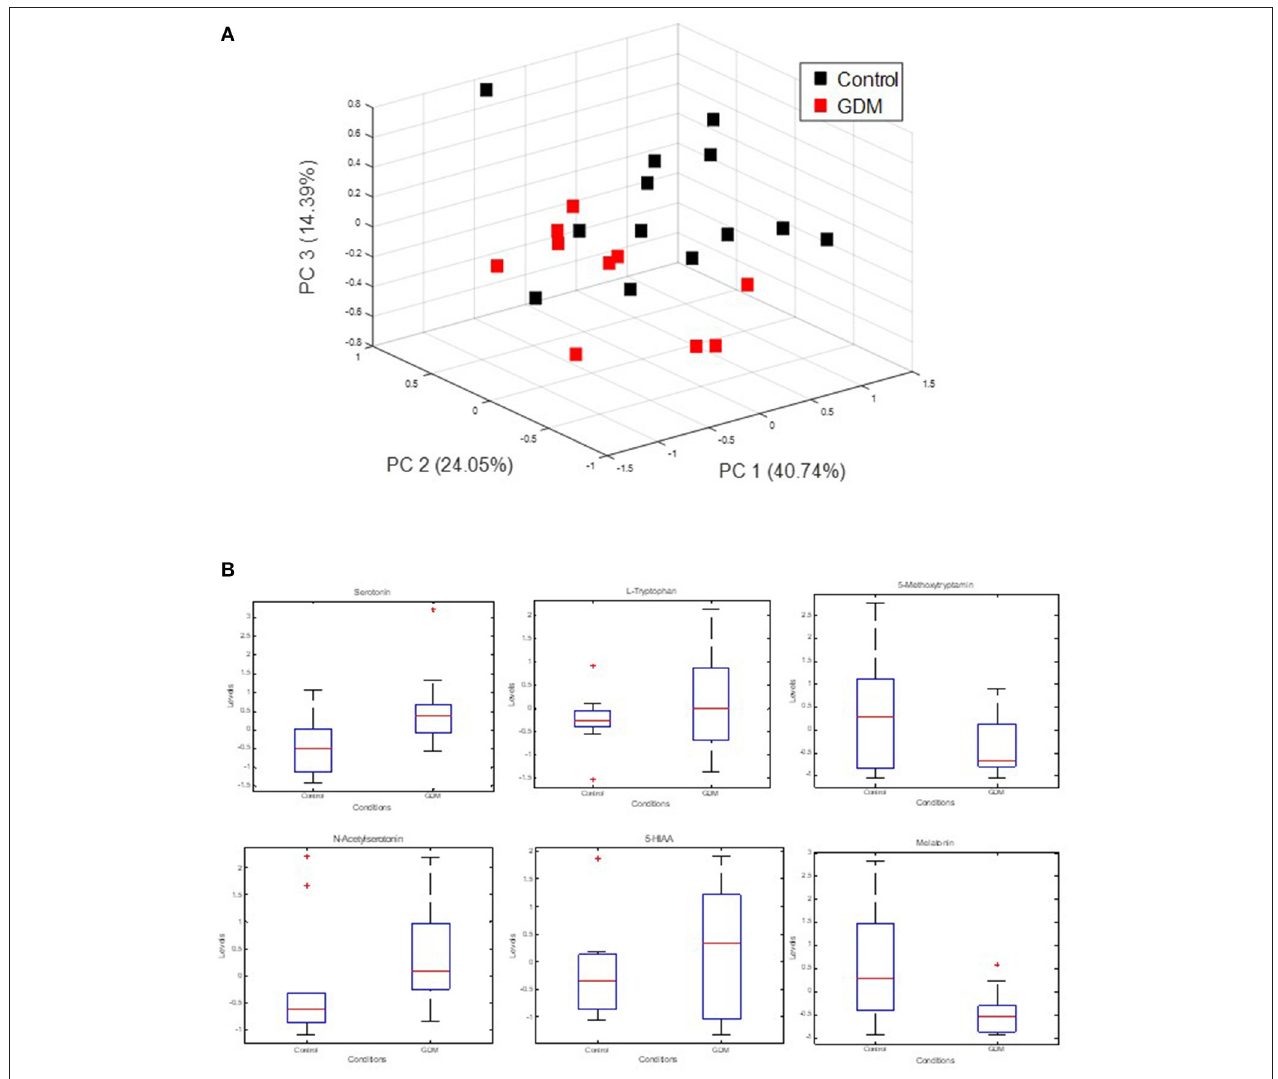
FIGURE 2 | Measurement of extracellular serotonin metabolic intermediates and dopamine in urine of GDM patients. (A) Principal component analysis of serotonin metabolic intermediates. (B) Boxplots of serotonin metabolic intermediates in urine of GDM vs. control